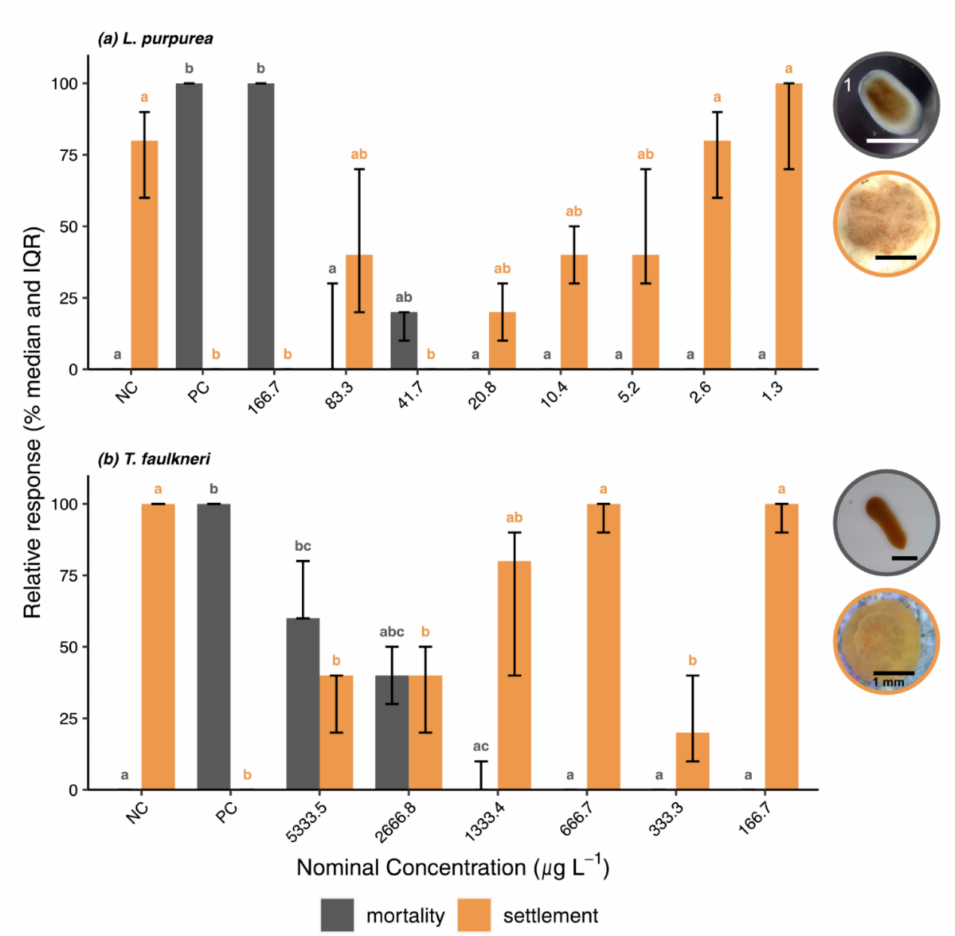
Figure 3. Results of the settlement assays with ( a ) Leptastrea purpurea and ( b ) Tubastraea faulkneri after 48 h exposure to BP3. Relative median mortality and settlement rate and interquartile range (IQR) are shown for each treatment (n = 3). Letters a – c indicate significance groups obtained from post hoc Dunn’s test, with same letters indicating no significant differences. Pictures (grey circle): swimming larva; pictures (orange circle): larva undergone settlement; Scale bar = 500 µ m unless indicated otherwise. NC = negative control (FSW for survival and FSW and CCA chip for settlement); PC = positive control; 1 Photo courtesy of L.